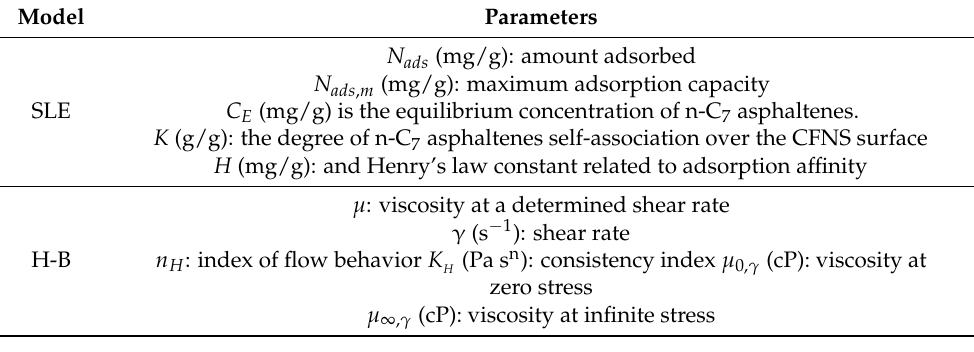
Table 1. Expressions and related parameters of the solid–liquid equilibrium (SLE) and Herschel– Bulkley (H-B)